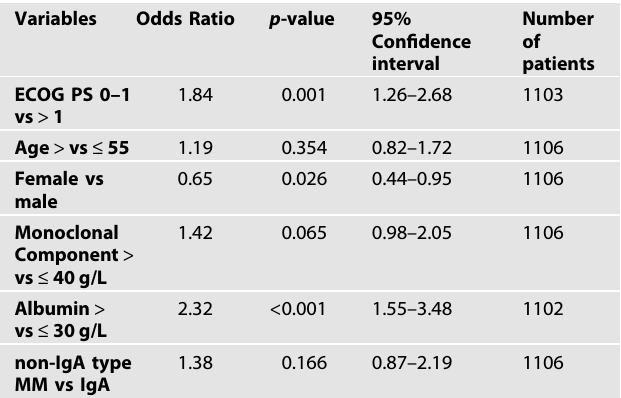
Table 3. Univariate logistic regression